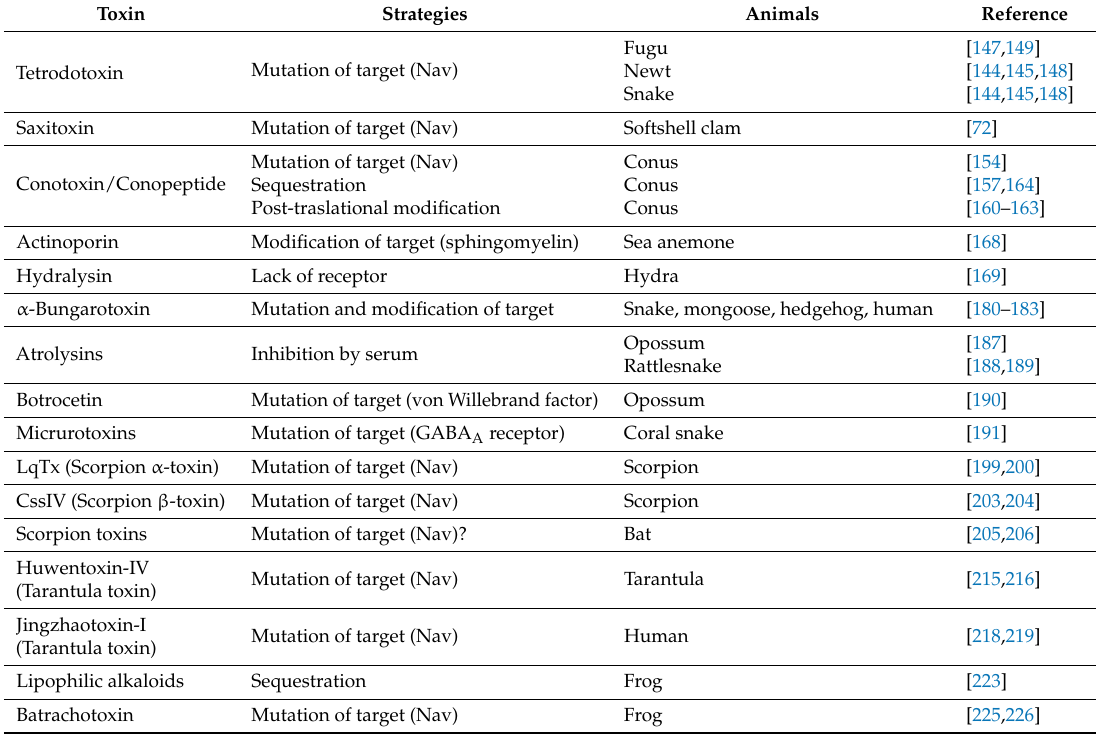
Table 2. Toxin resistance-related strategies in marine and terrestrial